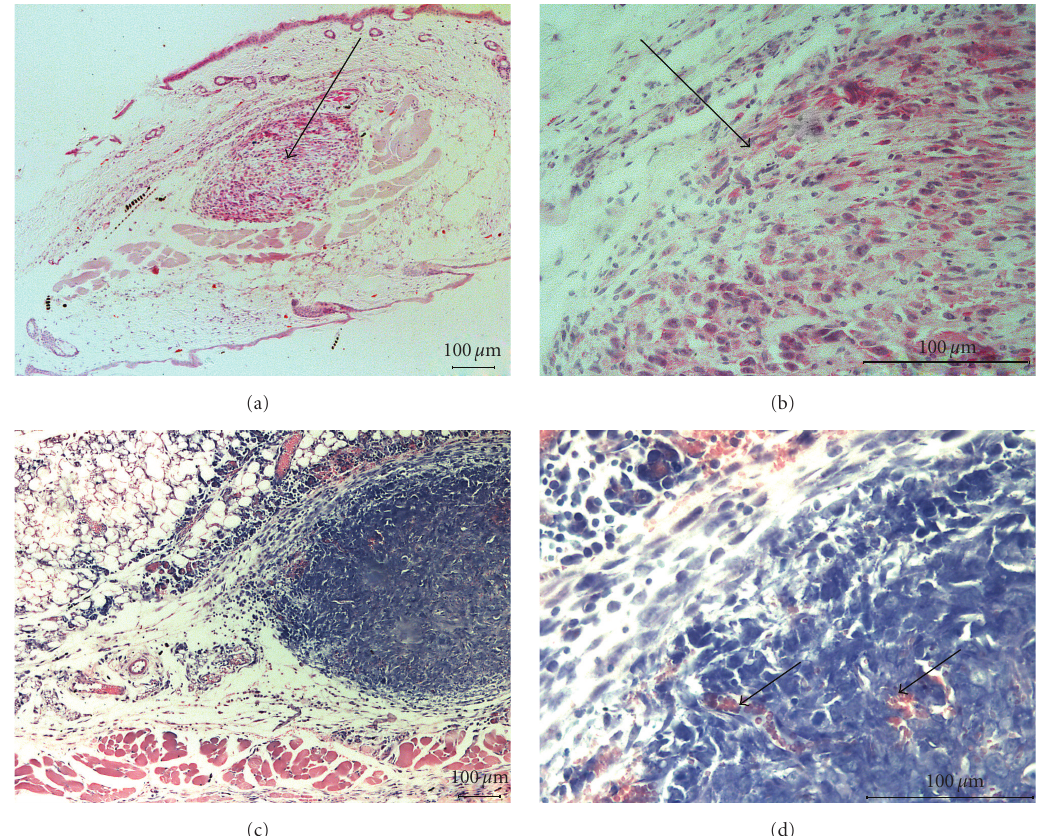
Figure 5: Microphotographs of hepatoma 22a (a) Tumor at 3 day after inoculation × 200 (b) higher magnification × 600: Polymorphous, separately lying tumor cells, no reaction from peripheral tissue. Tumor tissue is shown by arrows. Hematoxylin-eosin staining (c) tumor at 7 day after inoculation × 200 (d) higher magnification × 600. The appearance of new vessels in the tumor tissue shown by arrows. (Azure-II- eosin